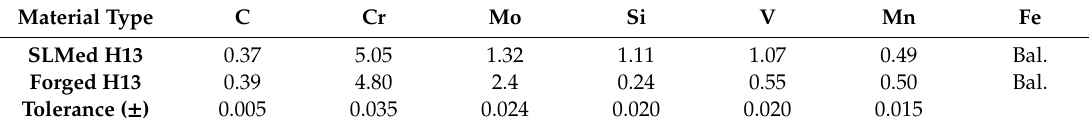
Table 1. Chemical compositions of the di ff erent H13 steel materials (weight